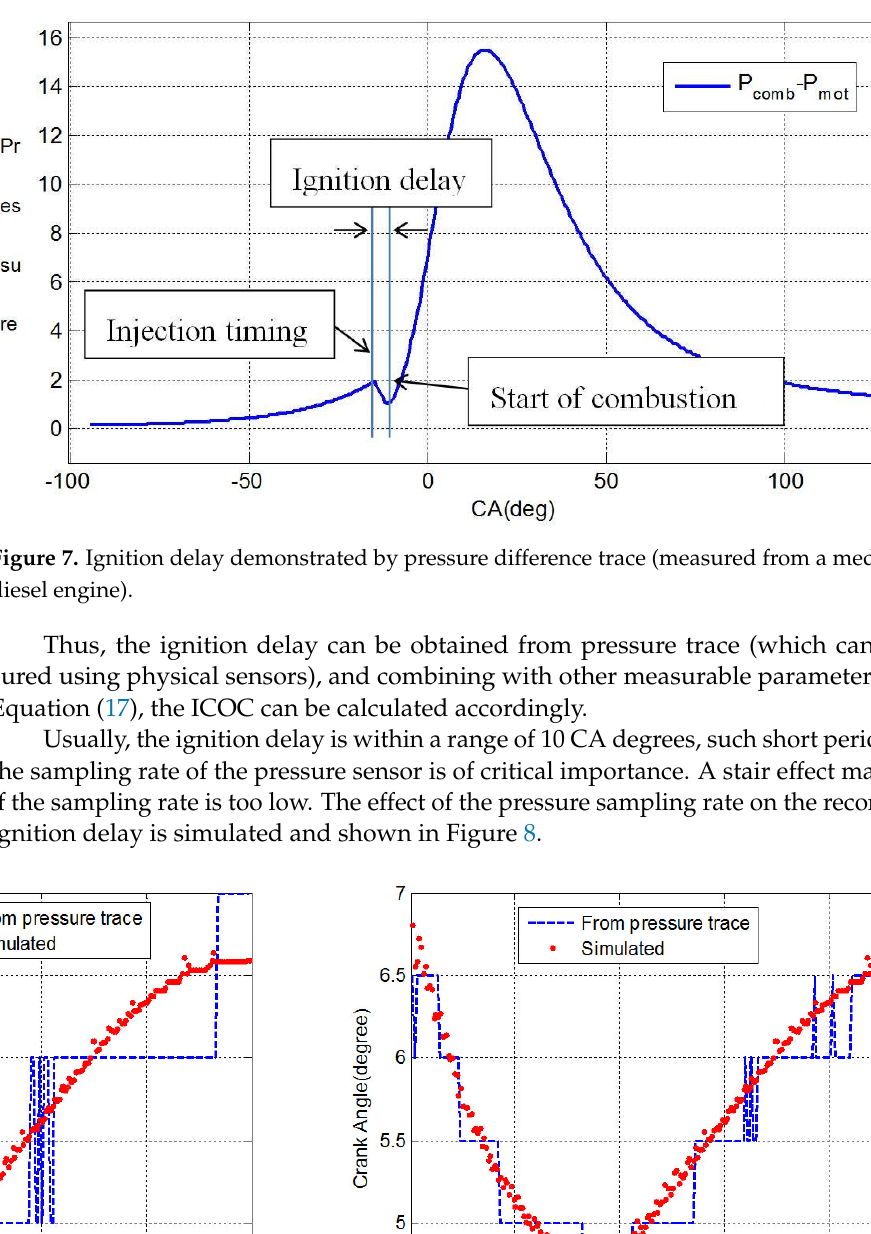
Figure 8. Ignition delay reconstructed by pressure trace with different sampling rate: ( Left ) Pressure sampled for every 1CA degree. ( Right ) Pressure sampled for every 0.5 CA degree.